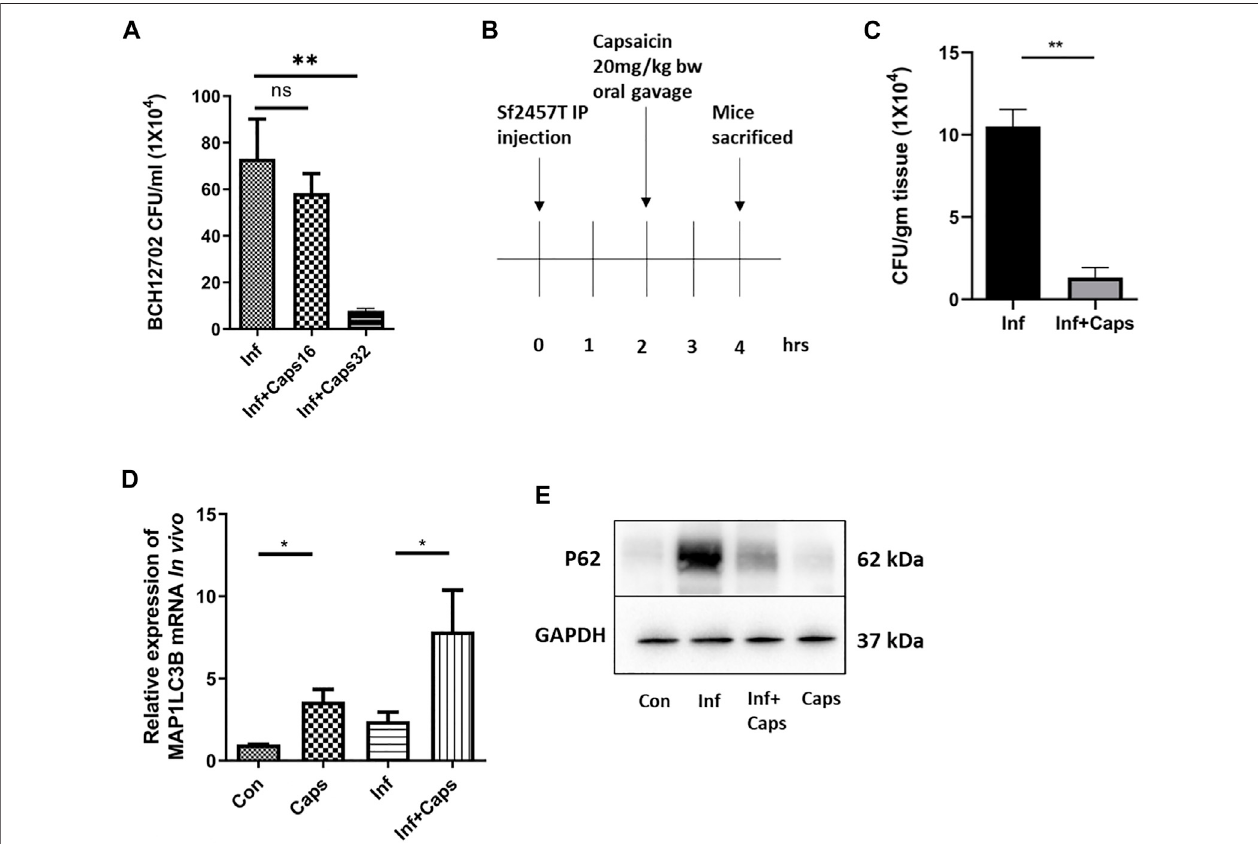
FIGURE7| Capsreducedbacterialgrowthinbothcellularand invivo conditions. (A) Cellswereinfectedwithresistant S. fl exneri2a (BCH12702)strainfollowedby 16 μ M, 32 µM Caps post-treatment for 12 h and CFU/ml was graphically represented. One-way ANOVA was performed. (B) Caps treatment in Shigella fl exneri 2457T - infected BALB/c mice. Brie fl y, mice were infected for 2 h followed by Caps (20 mg/kg b. w.) treatment for 2 h. Four groups (N = 4) were created accordingly: Group 1. Control:onlyDMSOwasusedasthevehicle.Group2.Infected:Received S. fl exneri suspension(0.5×10 9 CFU/ml)inPBS.Group3.Infected+Caps:Received S. fl exneri suspensionfollowedbyCaps(20 mg kg − 1 bodyweight)treatmentfor2 h.Group4.Caps:ReceivedCaps(20 mgkg − 1bodyweight).Eachgroupwaskeptinan individual cage. Experiments were repeated in triplicate (n = 3). Total number of mice in each group were 12. (C) CFU was counted and plotted for S. fl exneri sf2457T infected and infected + Caps-treated crushed colon samples. Unpaired t -test was performed. (D) qRT-PCR was performed for the expression of the autophagy- associated marker gene MAP1LC3B in control, infected, infected with caps treatment, and only Caps-treated mice tissues using GAPDH as a housekeeping gene control. One-way ANOVA was performed. (E) Expression of major autophagy-associated marker protein P62 was observed in western blot. GAPDH was used as a loading control. Graphs were represented using GraphPad Prism 5 as mean ± SEM (n = 3); signi fi cance was calculated: * p < 0.05, ** p < 0.01, *** p <